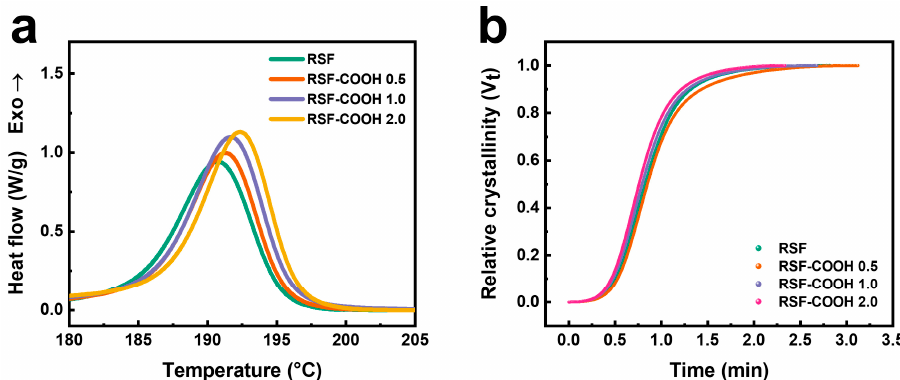
Figure 4. DSC thermograms cooled at 10 °C/min ( a ) and plots of relative crystallinity ( V t ) vs time ( b ) for non-isothermal crystallization of RSF composites with various HBP contents. Table 2. DSC data for RSF containing various HBP contents under non-isothermal crystallization.